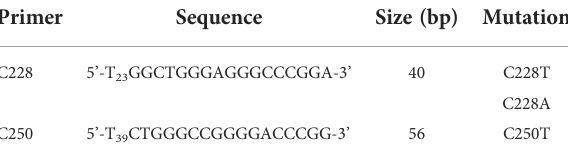
TABLE 3 SNaPshot primers used for detection of TERT promoter mutation. Primer